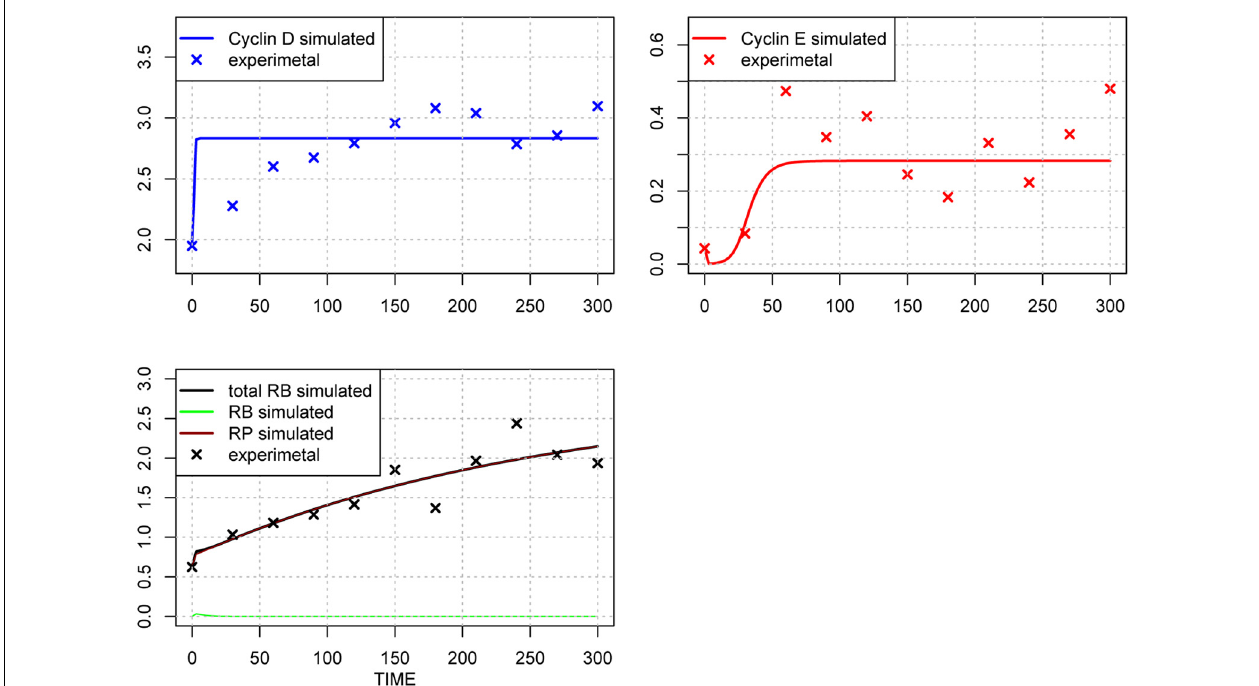
FIGURE 6 | Time-course of protein concentrations in the model. The x-axis indicates the Time [min], the y-axis indicates the concentration of the species [nM]. The upper left panel shows Cyclin D (line: simulation result, cross: experimental result), upper right panel shows Cyclin E (line: simulation result,